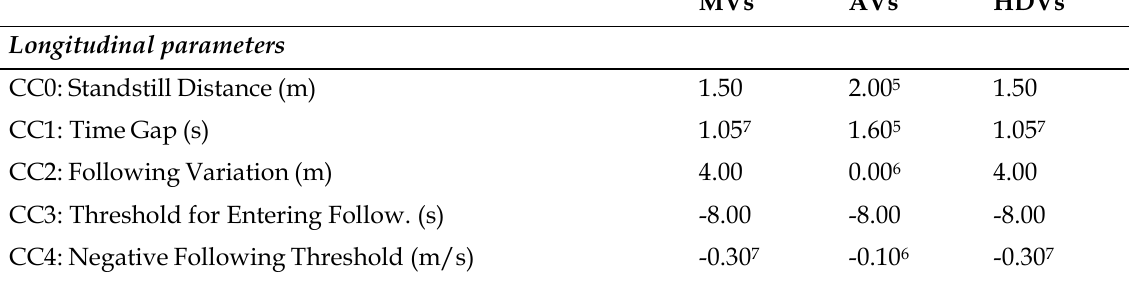
Table 3. Wiedemann99 parameters used for manually driven cars (MVs), automated cars (AVs) and heavy-duty vehicles